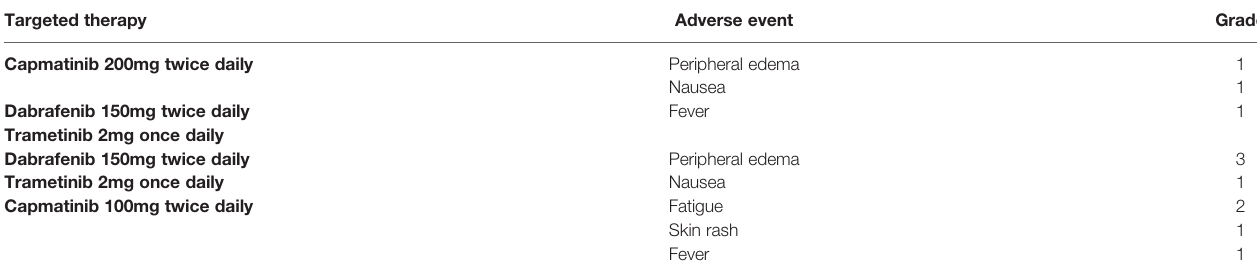
TABLE 2 | The toxicity pro fi le of the combination therapy of dabrafenib, trametinib, and capmatinib. Targeted therapy